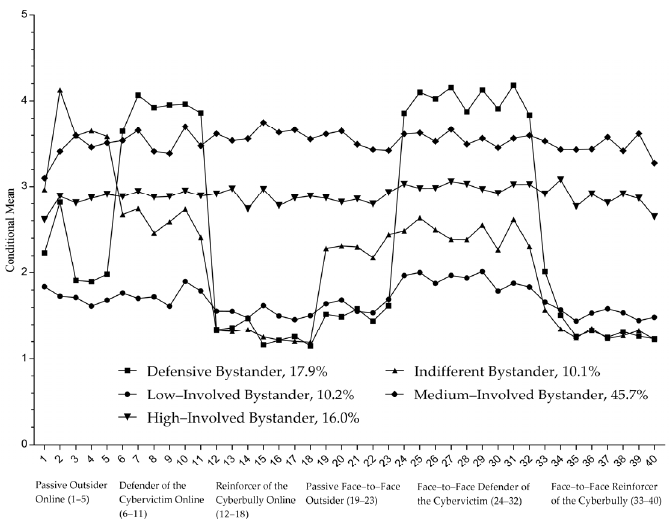
Figure 1. Five classes of the cyberbullying bystander (CBS) of the best fitting five class pattern.